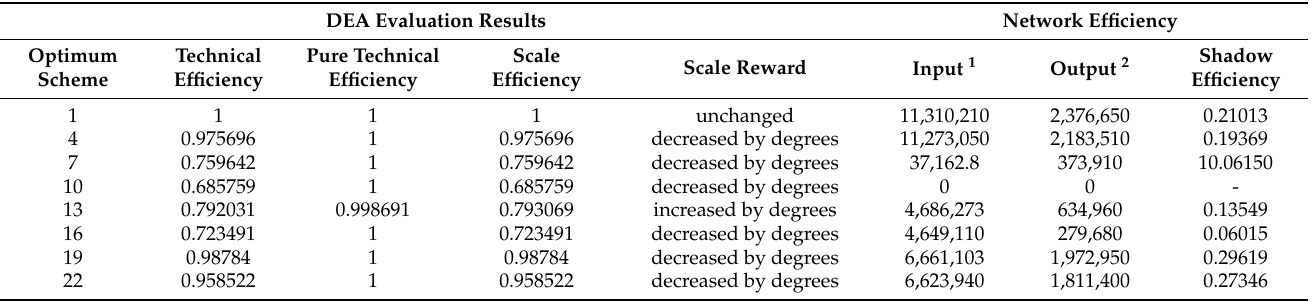
Table 9. DEA evaluation results of each program for the original passenger flow